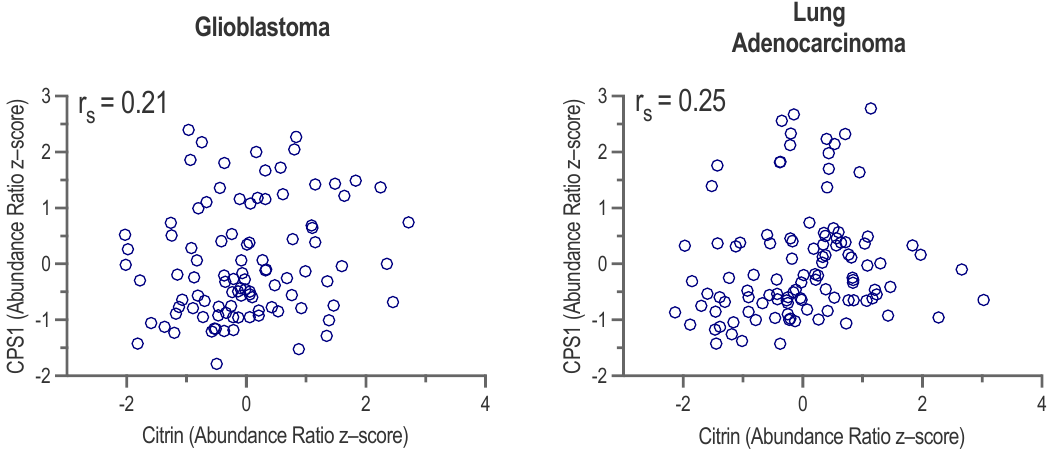
Figure 7. Correlation between NAGS and CPS1 mRNA expression (top), NAGS and citrin mRNA expression (middle), and citrin and CPS1 mRNA expression (bottom) in individual glioblastoma, glioblastoma multiforme, lung adenocarcinoma, and stomach glioblastoma samples. Spearman correlation coefficient was calculated to infer the relationship between mRNA expression levels in individual tumor samples.